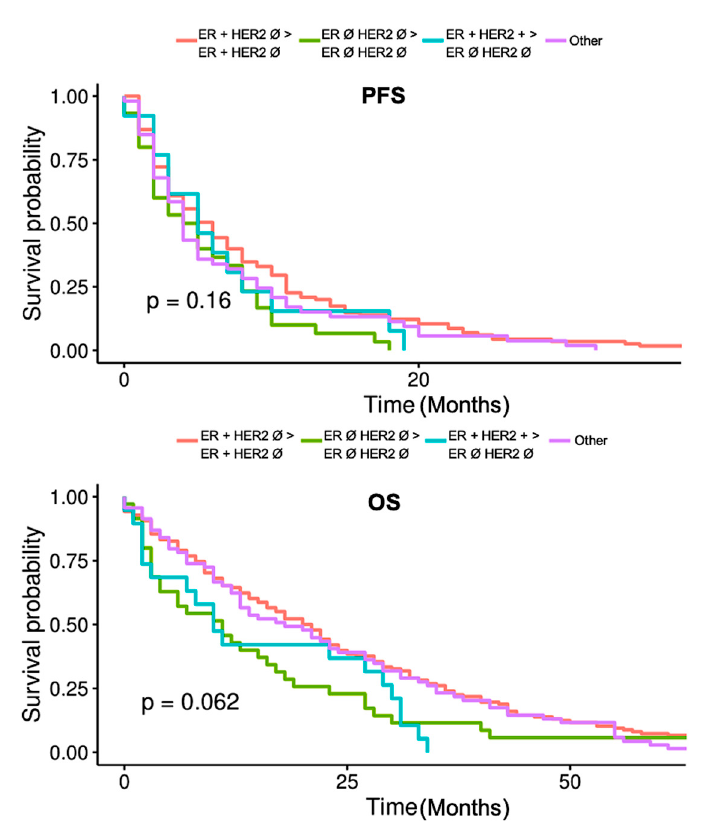
Figure 3. PFS and OS comparison between four patient subgroups based on therapeutically relevant receptor change or stable patterns between PTs and MTs. Ø—negative; ER—estrogen receptor; HER2 – human epidermal growth factor receptor 2.